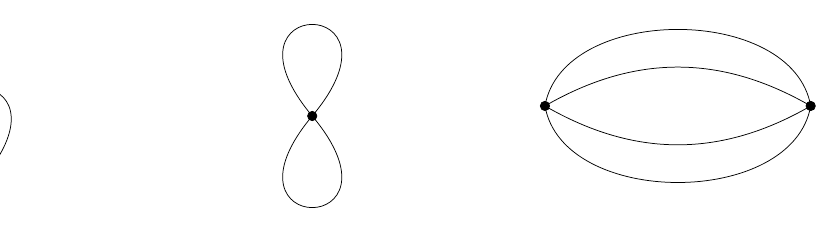
vertex, and it is of 2